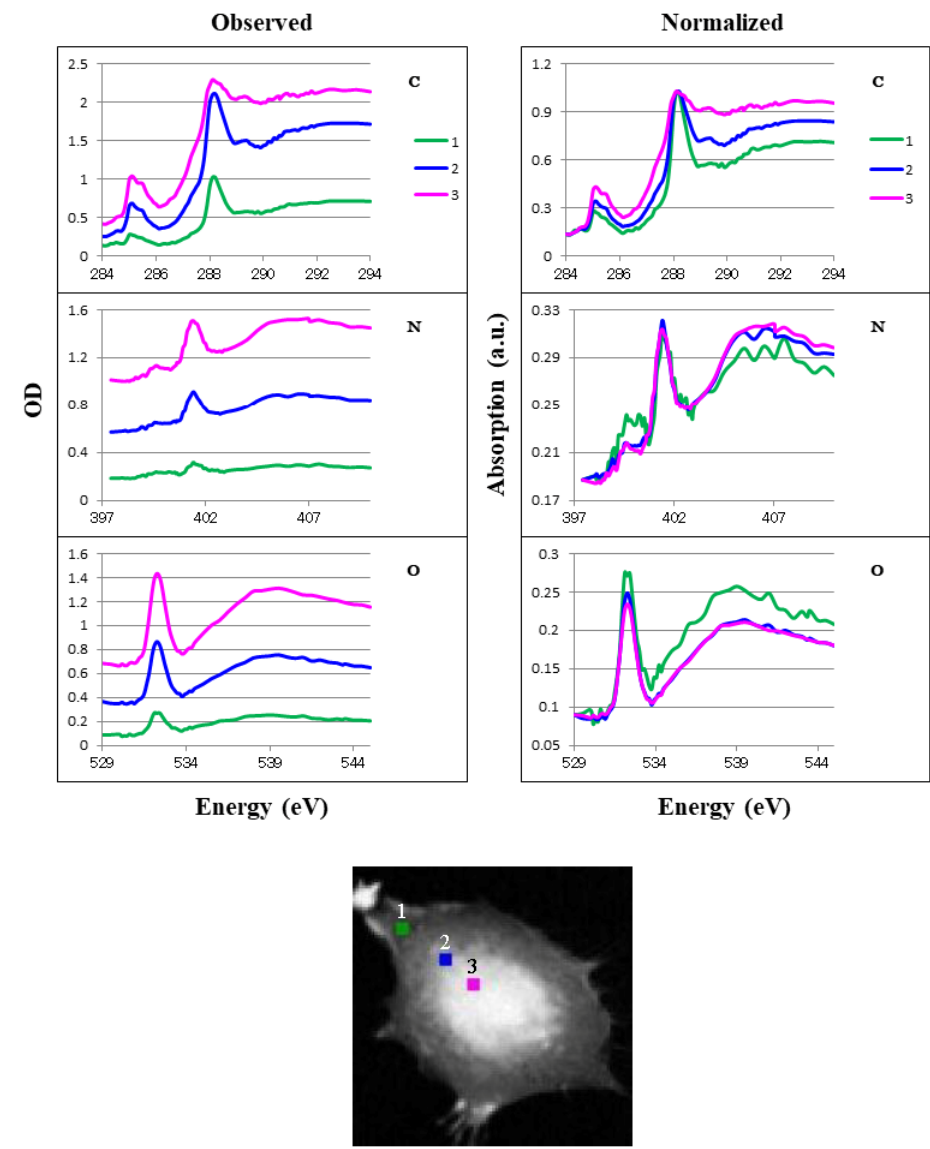
Figure 10. Absorption spectra of local areas in the CHO cell. Positions 1–3 are shown in the lower figure (area: 4 × 4 pixels each). Observed data are shown on the left, normalized data on the right. Numbers correspond to the positions of cytoplasm (1), cytoplasm near the nucleus (2), and the nucleus near its edge (3). C, N, and O are photon energy regions of the K absorption edges for carbon, nitrogen, and oxygen,